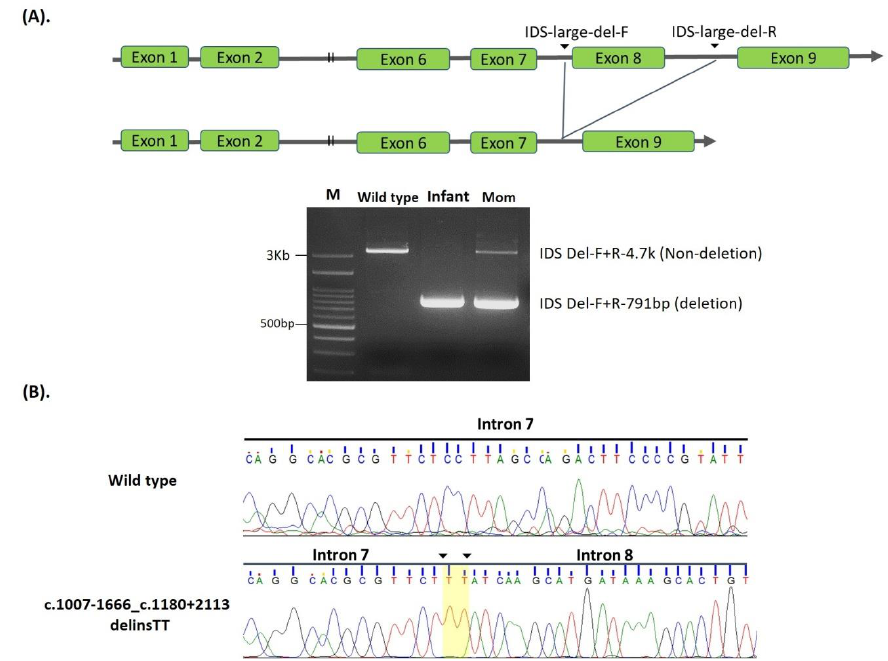
Figure 2. Scheme for generating a delins c.1007-1666_c.1180 + 2113delinsTT between intron 7 and